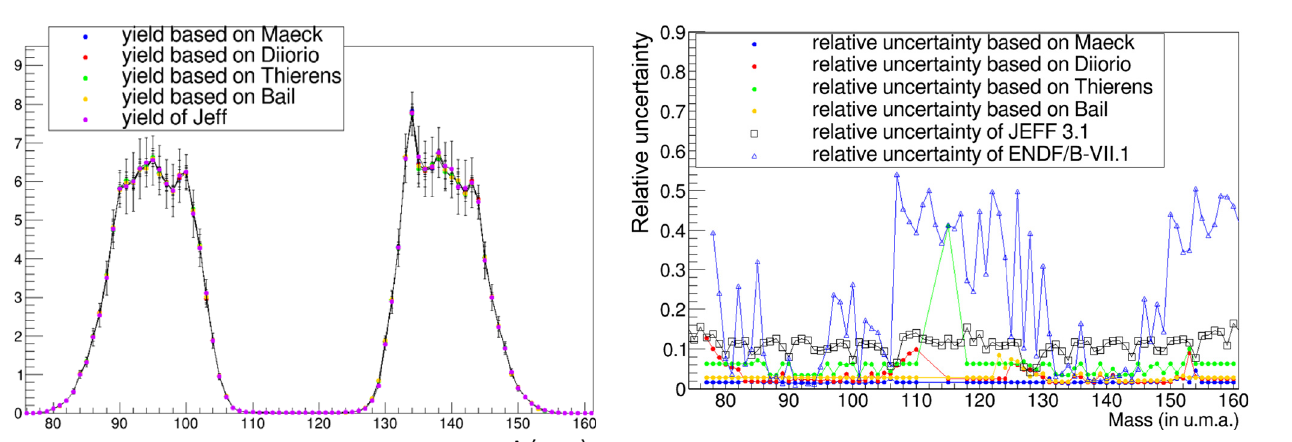
Fig. 5. Relative uncertainties of the different evaluations are displayed as a function of mass. Important discrepancies appear according to the choice of the reference yield data set.